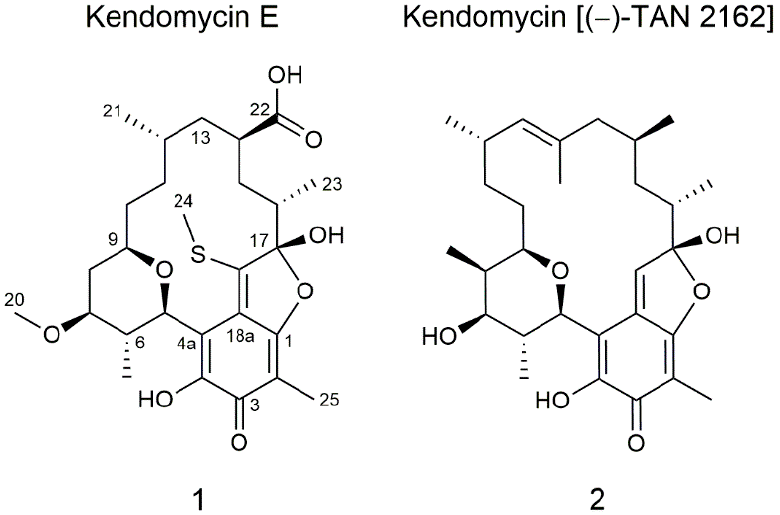
Figure 1. Chemical structures of the new kendomycin E ( 1 ) and the previously discovered kendomycin [( − )-TAN 2162] ( 2 ).